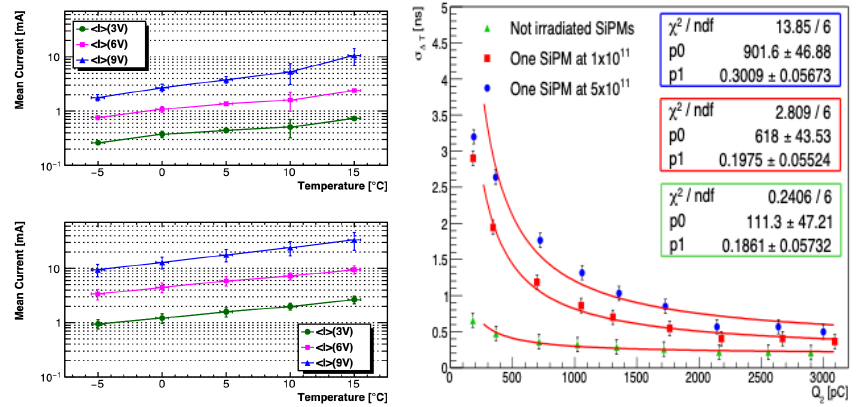
Figure 8. ( Left ) Idark dependence on SiPM temperature for different levels of neutron fluence (top, 10 11 , bottom 5 × 10 11 n 1MeVeq /cm 2 ) and overvoltages. ( Right ), time resolution dependence on charge for SiPM irradiated at different neutron fluences and running at 0 ◦